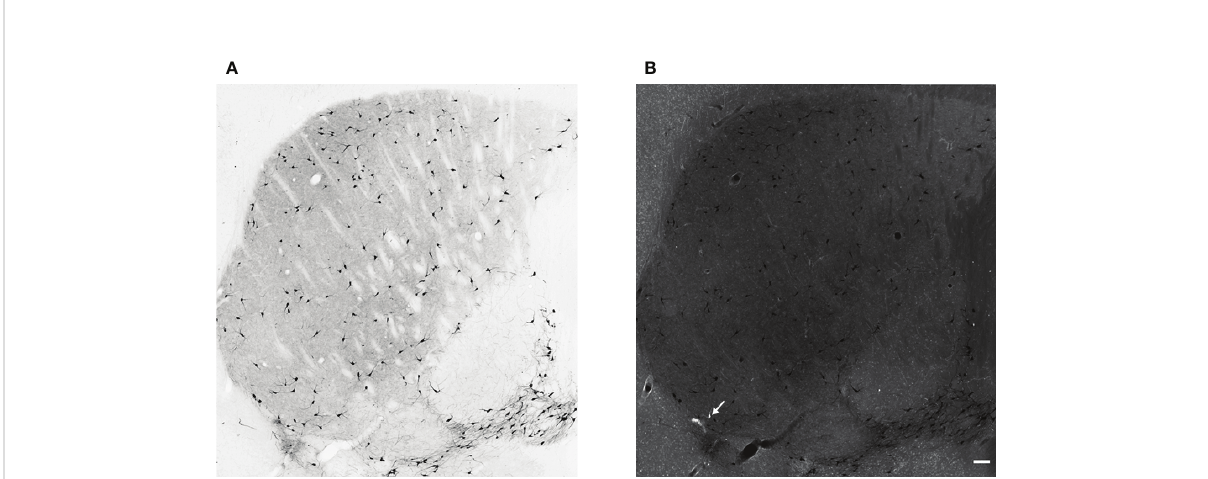
FIGURE 1 Cholinergic neurons in the striatum. Representative images of DAB immunohistochemistry for CHAT in the striatum from adult female ChAT- Cre-tdTomato transgenic mouse (Panel A , bright fi eld image, and Panel (B) , fl uorescence image). In panel B the white cell represents non- cholinergic but tdTomato-positive cells (white arrow), whereas cholinergic, CHAT-positive interneurons are black in both panels. 10x magni fi cation, scale bar represents 100 m